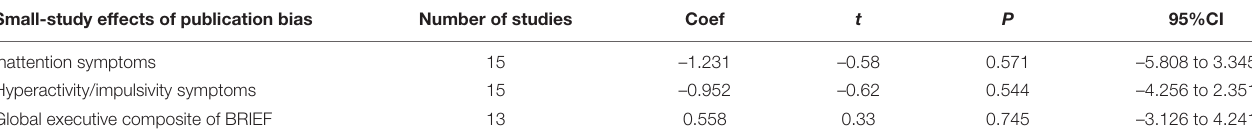
TABLE 4 | Publication bias with Egger’s